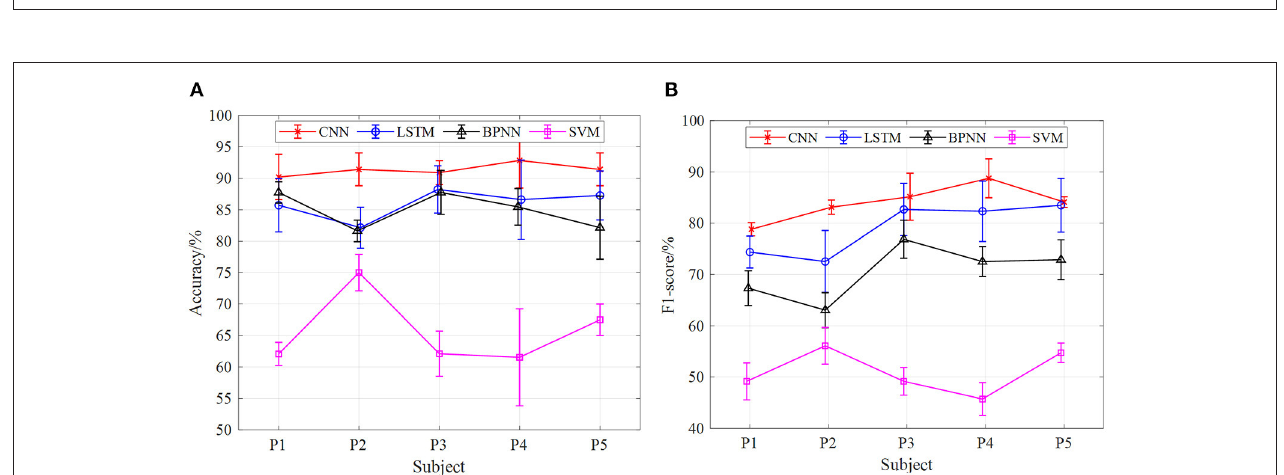
FIGURE 9 | The results of gait phase classification of different models with the 5-fold cross-validation method at 1km/h, (A) the average accuracy of gait phase classification of different models of five subjects, (B) the average F1-score of gait phase classification in different models of five subjects.